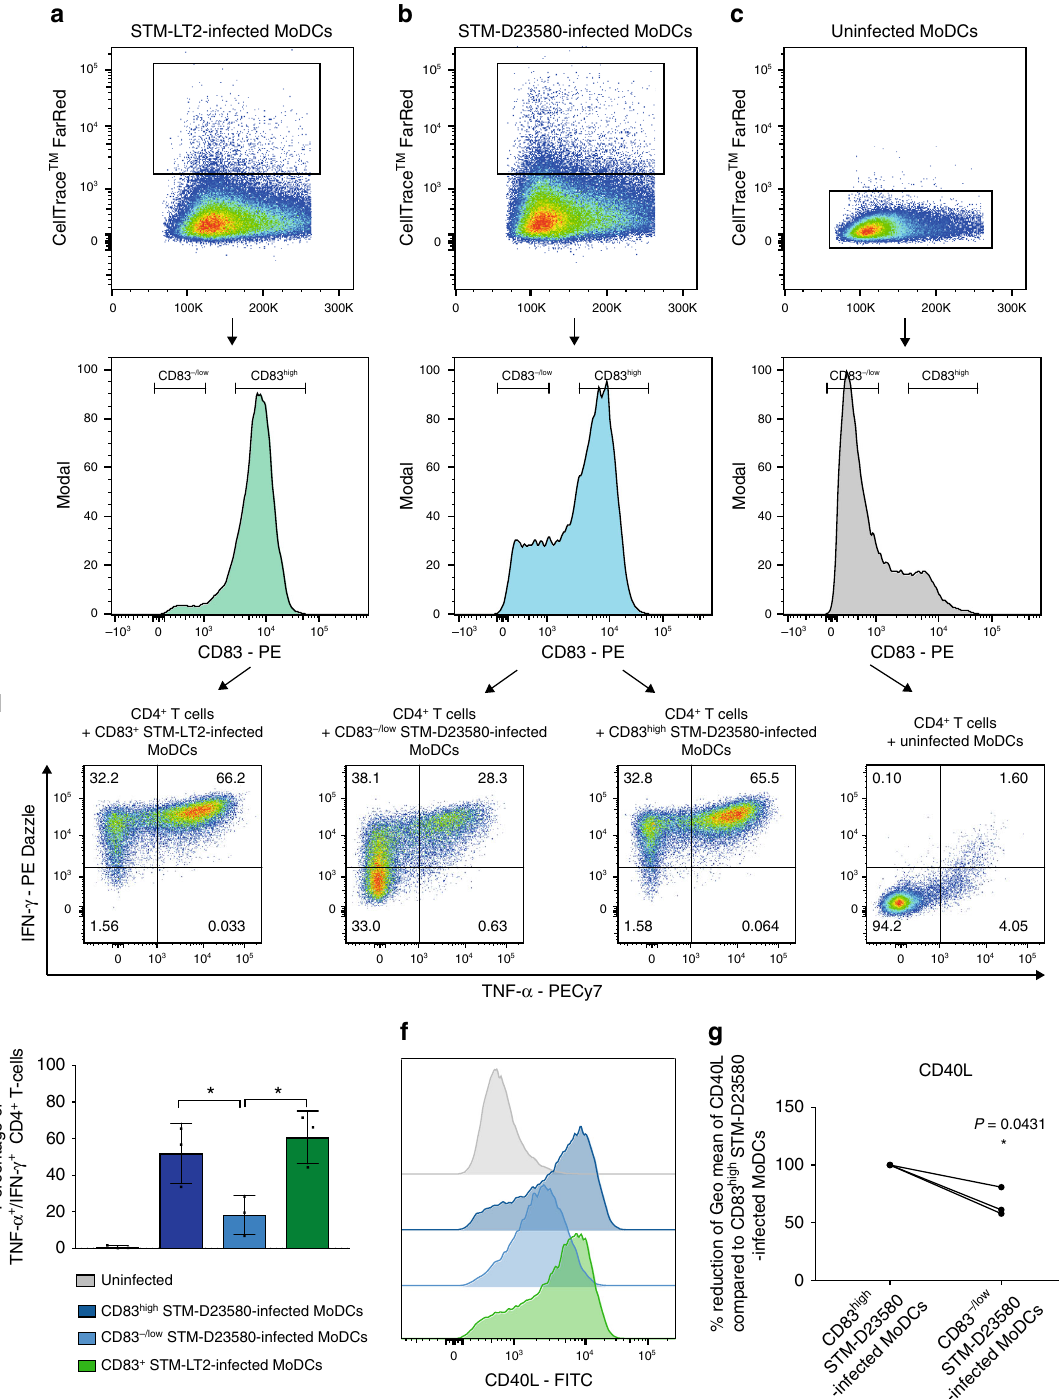
Fig. 8 CD83 -/low STM-D23580-infected MoDCs direct defective activation of Salmonella -speci fi c CD4 + T cells. At 6 h p.i., a STM-LT2-infected MoDCs were sorted as CD83 + while b STM-D23580-infected MoDCs were sorted as CD83 -/low or CD83 high . c Uninfected MoDCs were used as negative control. Sorted subsets of infected MoDCs were co-cultured overnight with PhoN-speci fi c CD4 + T cell clones cross-reactive against typhoidal and non-typhoidal serovars. d Capacity of CD4 + T cell to secrete IFN ‐ γ and TNF- α , as detected by intracellular staining. FACS plots show the percentage of IFN ‐ γ + /TNF- α + cells out of total CD3 + CD4 + T cells. Dot plots comprise a representative experiment out of four. e CD83 − /low STM-D23580-infected MoDCs induce a signi fi cantly lower amount of cytokine-producing T cells, as compared to CD83 high STM-D23580 or CD83 + STM-LT2 infected cells. The mean±SEM of three independent experiments is shown One-way ANOVA test, P -value < 0.05 (*). f Flow cytometry histogram showing CD40L expression on T cells co- cultured with CD83 + STM-LT2 infected MoDCs, CD83 − /low or CD83 high STM-D23580-infected cells. Histograms from one representative example of at least three biological replicates. g Geometric mean of fl uorescence intensity for CD40L in T cells co-cultured with CD83 − /low STM-D23580-infected MoDCs, represented as a percentage of reduction from CD83 high STM-D23580-infected MoDCs. three independent experiments are shown. Two-tailed paired Student ’ s t -test, P -value < 0.05